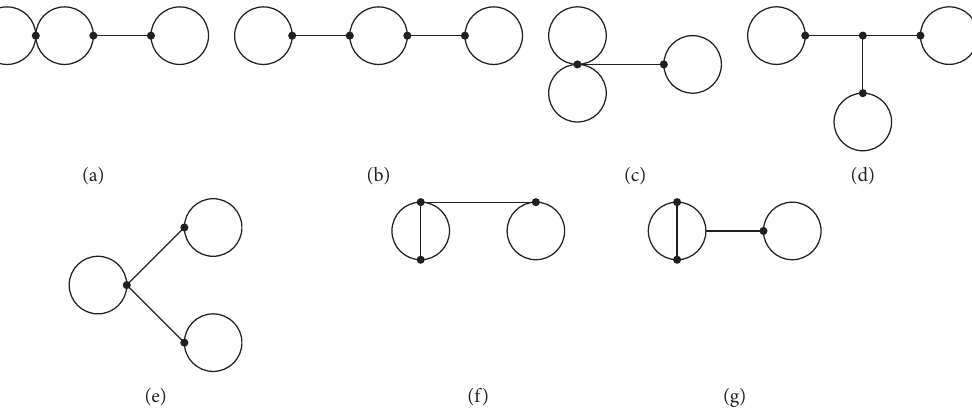
Figure 3: Seven underlying graphs of tricyclic signed graphs in case 1.